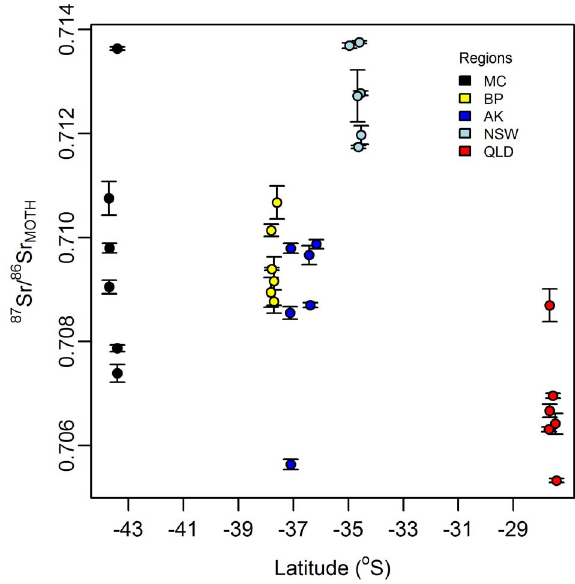
Figure 3. H.armigera 87 Sr/ 86 Sr distribution, relative to degress latitude south. Error bars = analytical